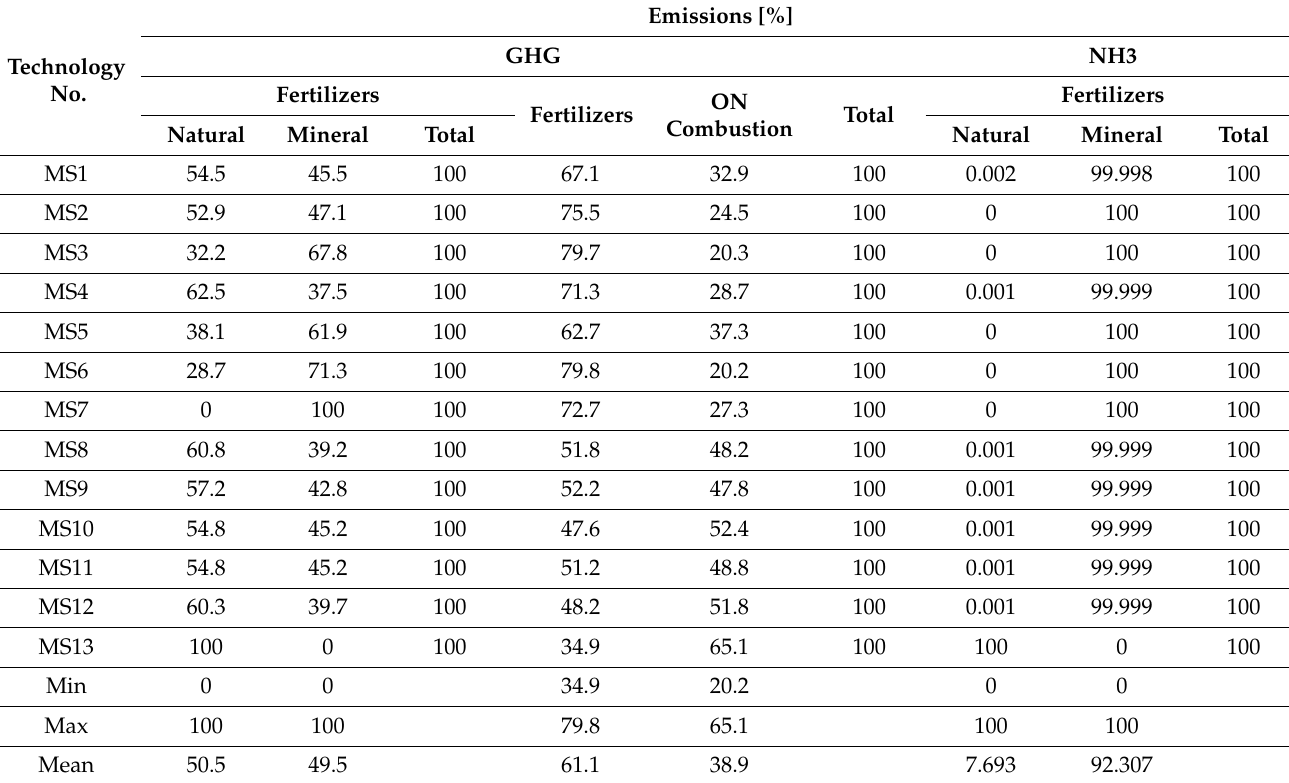
Table 7. Percentage share of GHG and NH 3 emissions from the sources studied in the total emissions.